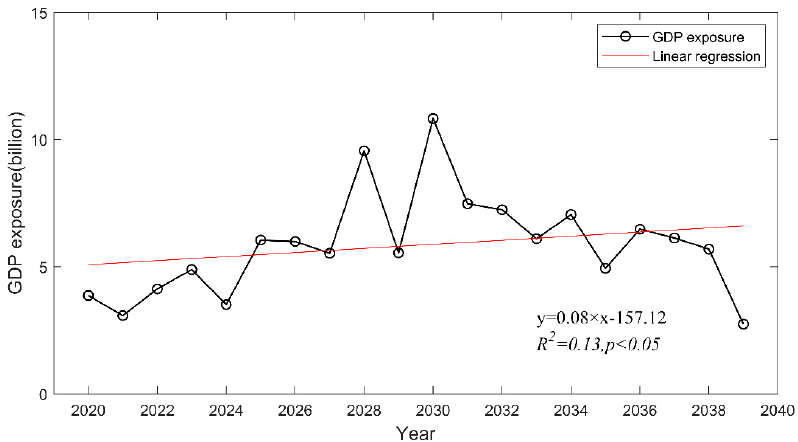
Figure 7. Impact of extreme precipitation events in the Loess Plateau on the annual GDP exposure for 1.5 °C global warming.